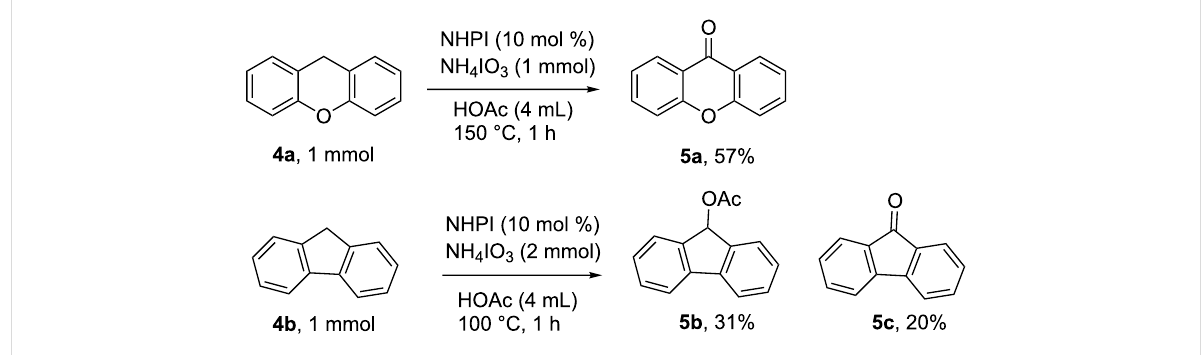
opposed to the propyl group attached to the benzene ring. We